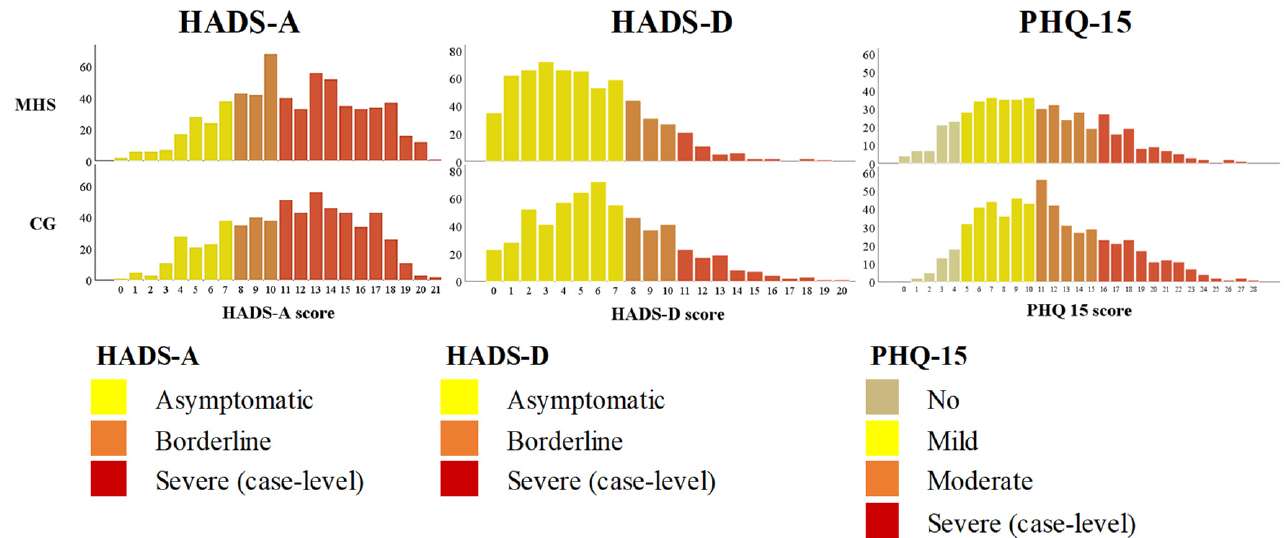
Figure 2. Distribution of HADS-A, HADS-D, PHQ-15 scores between the samples of female students of the groups of medicine and health sciences (MHS) and the comparison group (CG): natural sciences, social sciences, technological sciences, agricultural sciences, technological sciences, humanities and arts.